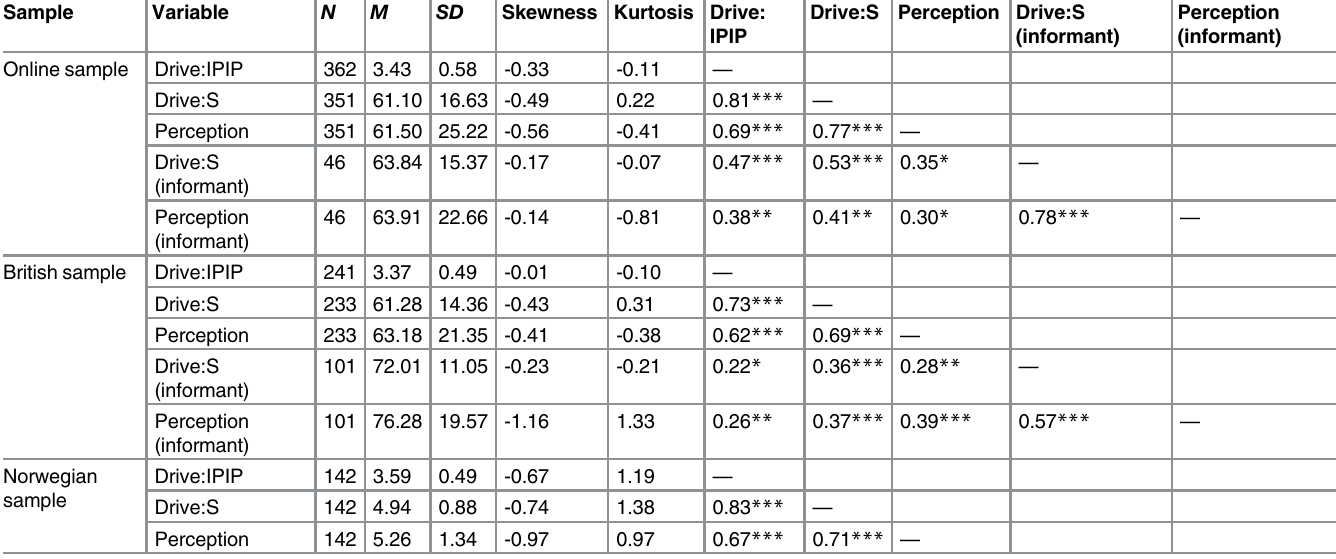
Table 6. Descriptive Statistics and Bivariate Correlations among Drive:IPIP, Drive:S, and Motivation Perceptions in the Online, British, and Norwe- gian Samples.